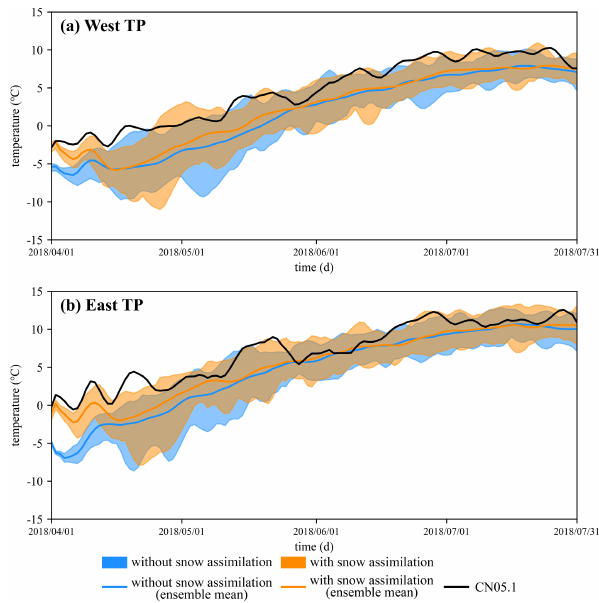
Figure 6. The daily temperature time series averaged over the do- main from 1 April to 31 July for the two ensemble reforecasts and CN05.1 data in the (a) western Tibetan Plateau and (b) eastern Ti- betan Plateau.